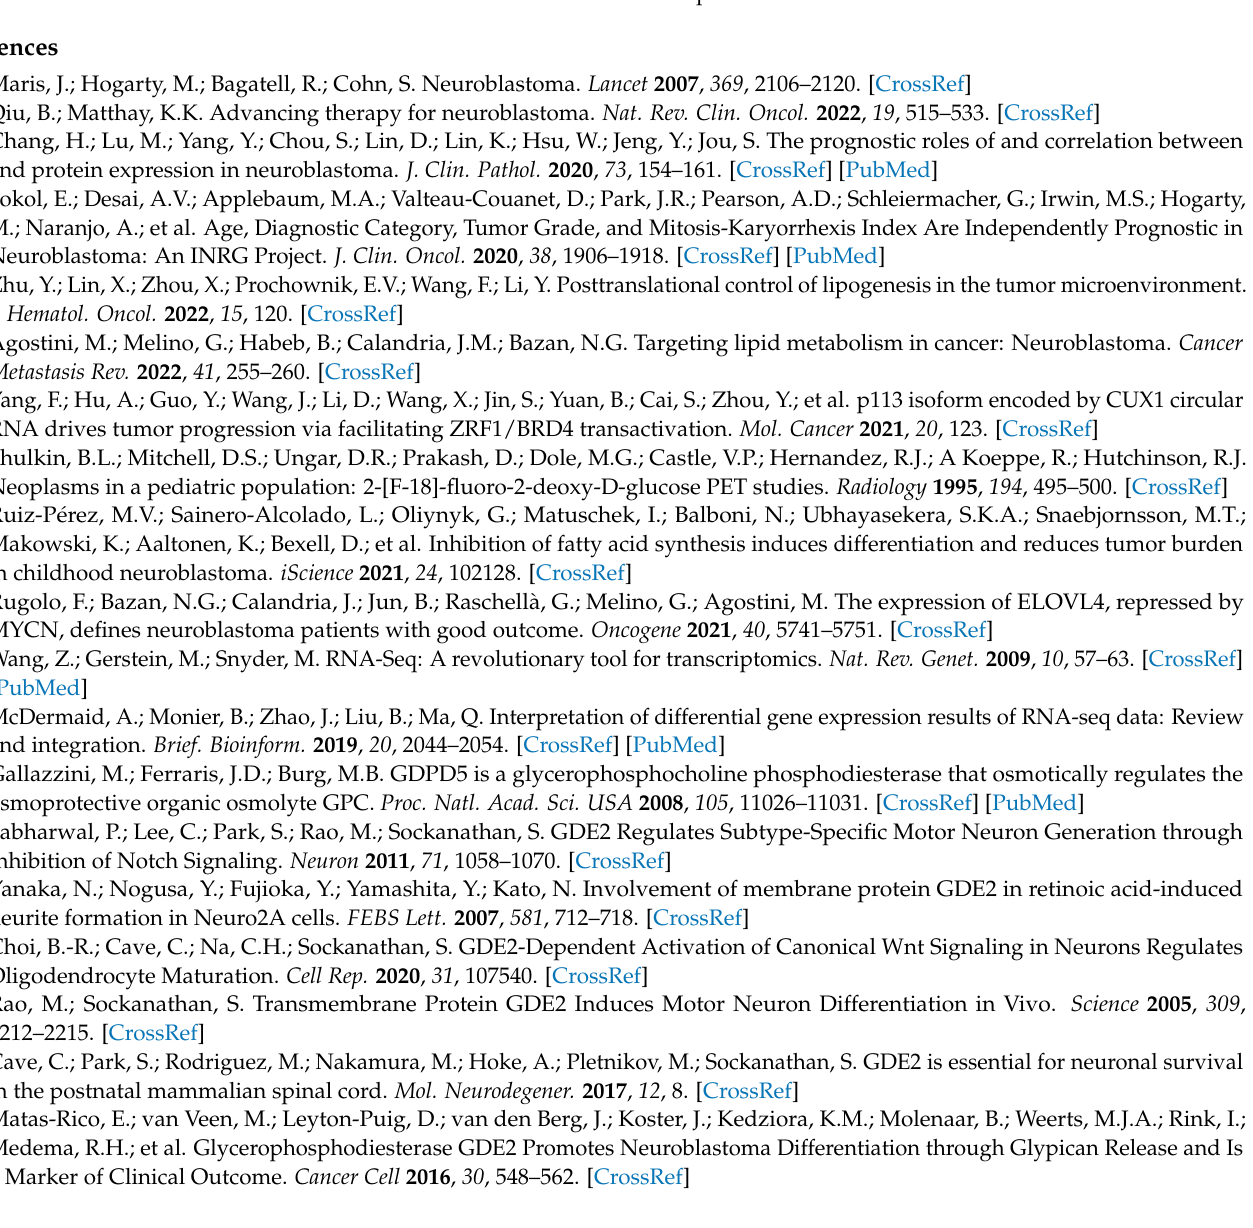
8 kinds of immune cells. The horizontal axis is the expression of GDPD5 and the vertical axis is immune